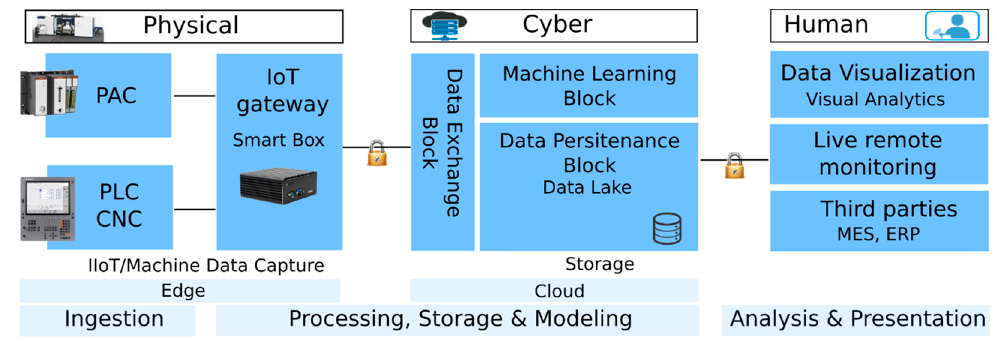
Figure 9. Block diagram of the Industrial Internet of Things (IIoT) platform for edge and cloud computing.